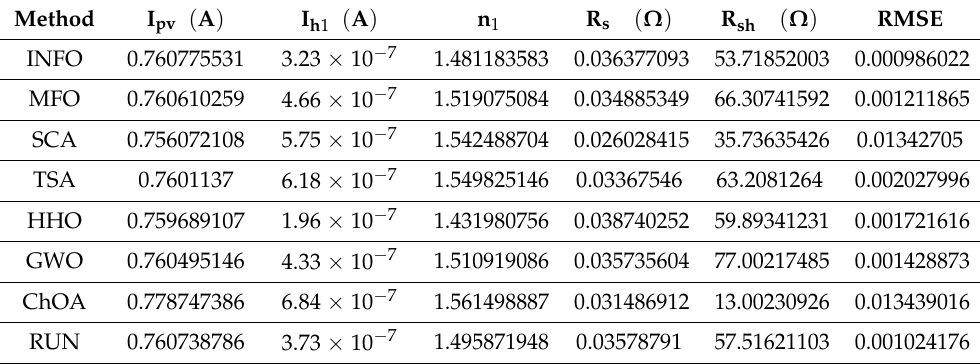
Table 3. The SDMSC’s identified parameters at the best